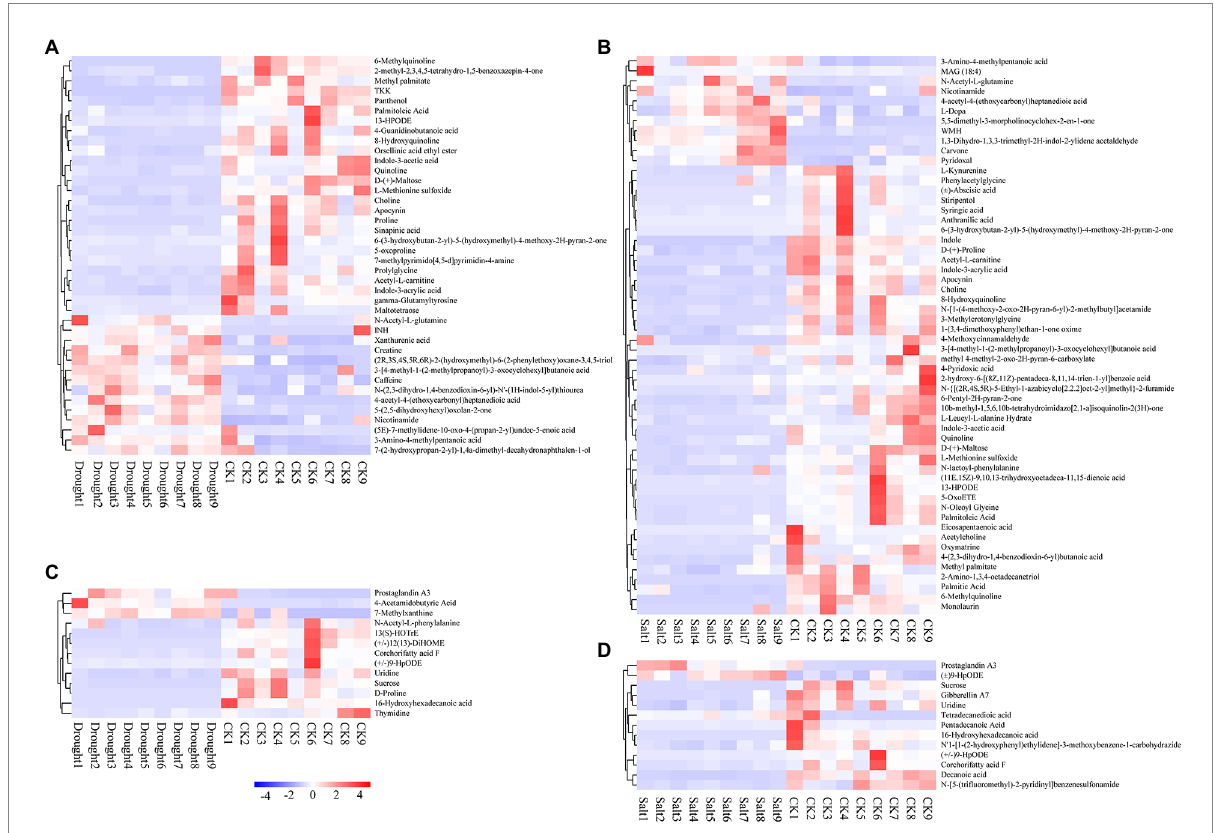
FIGURE 5 Heat map of clustering of differential metabolites of Nitraria tangutorum under drought ( A : pos and C : neg) and salt ( B : pos and D : neg)